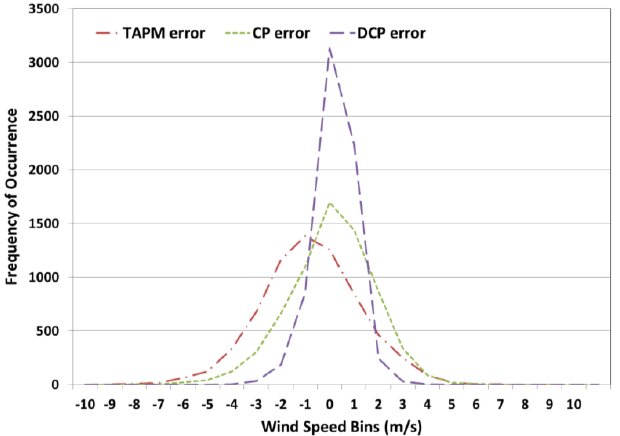
Figure 10. A histogram of the frequency of occurrence of wind speed errors for the TAPM predictions, the CP methodology and the DCP methodology for wind speeds within 3–15 m/s over